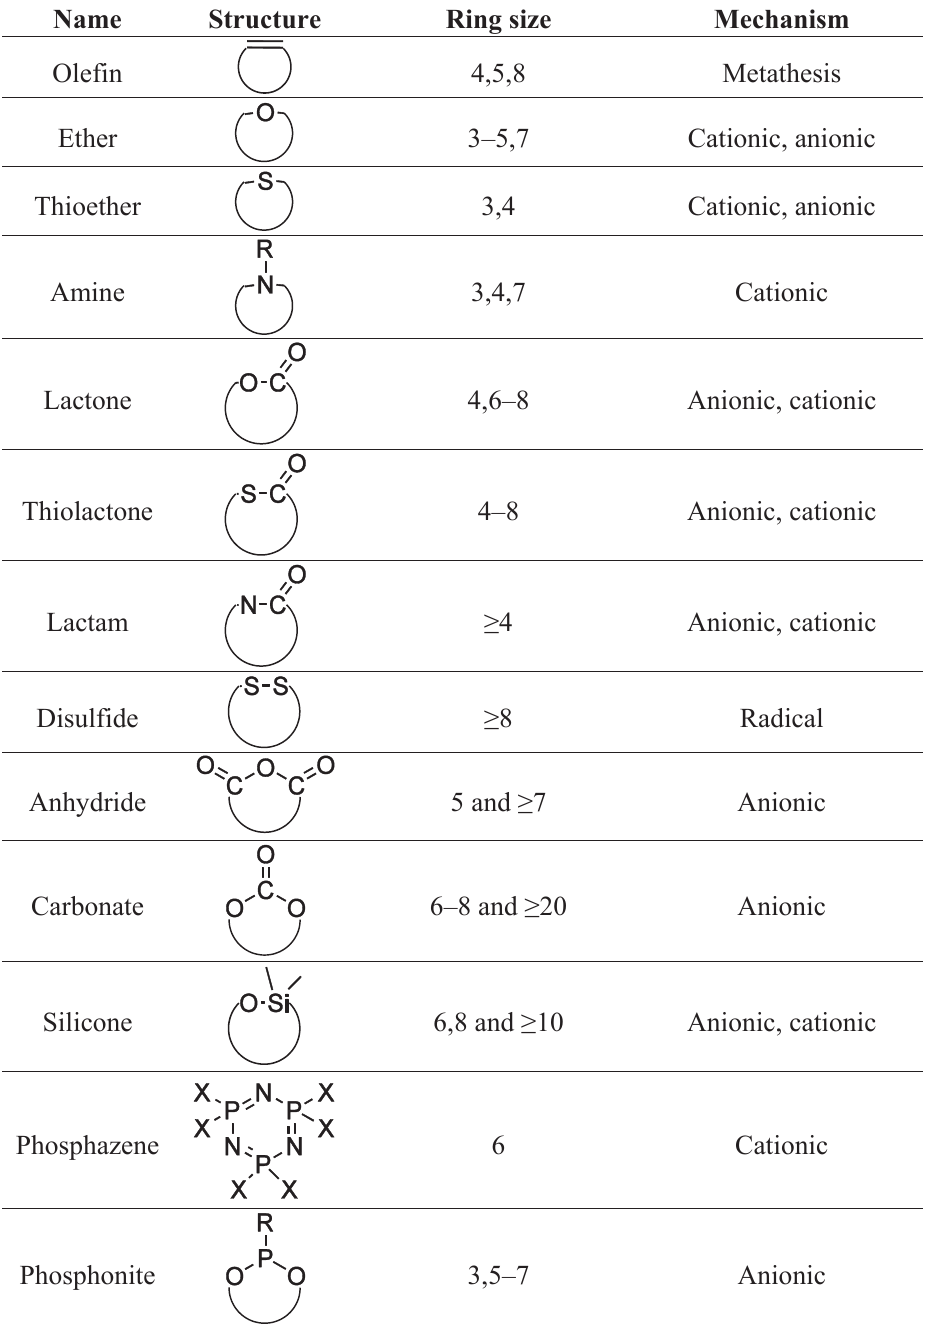
Table 1. Typical cyclic monomers and their usual polymerization mechanism